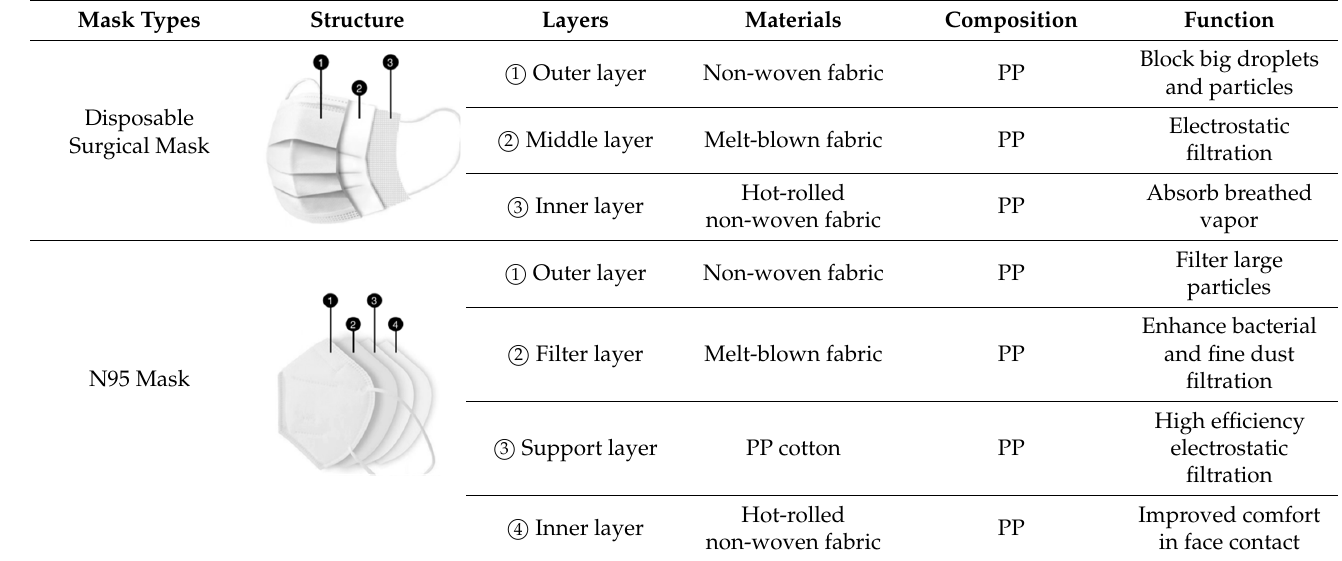
have approximately 11 and 4.5 g of PP and other plastic derivatives (e.g., polyethylene, polyurethane, polystyrene, polycarbonate, polyacrylonitrile), respectively [46,47].